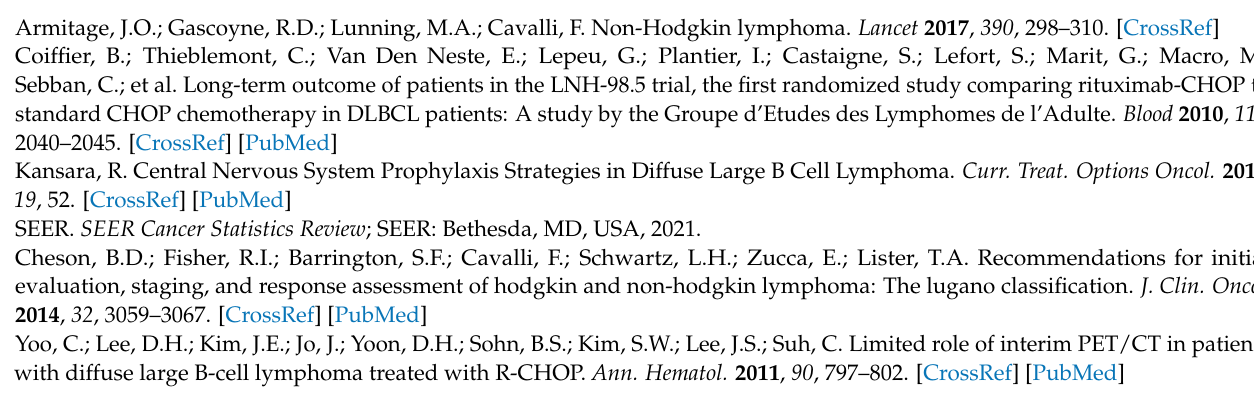
opment, Table S1: Radiomic features extracted for both the PET and CT components, Table S2: The hyperparameters explored within the grid